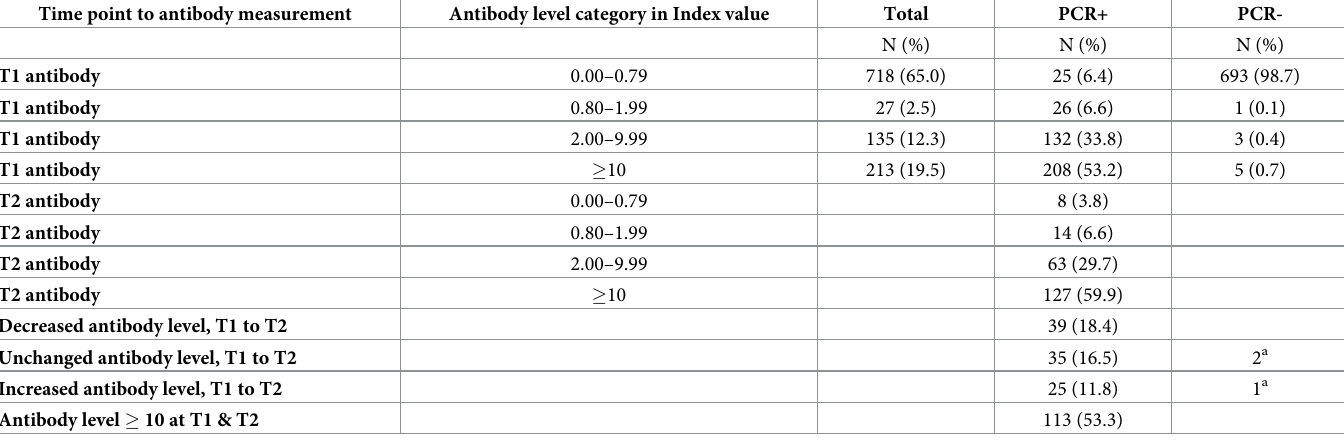
Table 2. The duration and changes in total antibody levels against the SARS-CoV-2 spike protein measured with Index value three to five months (T1) and 10 to 12 months (T2) after PCR test for PCR positive (PCR+) and PCR negative (PCR-) participants. Time point to antibody